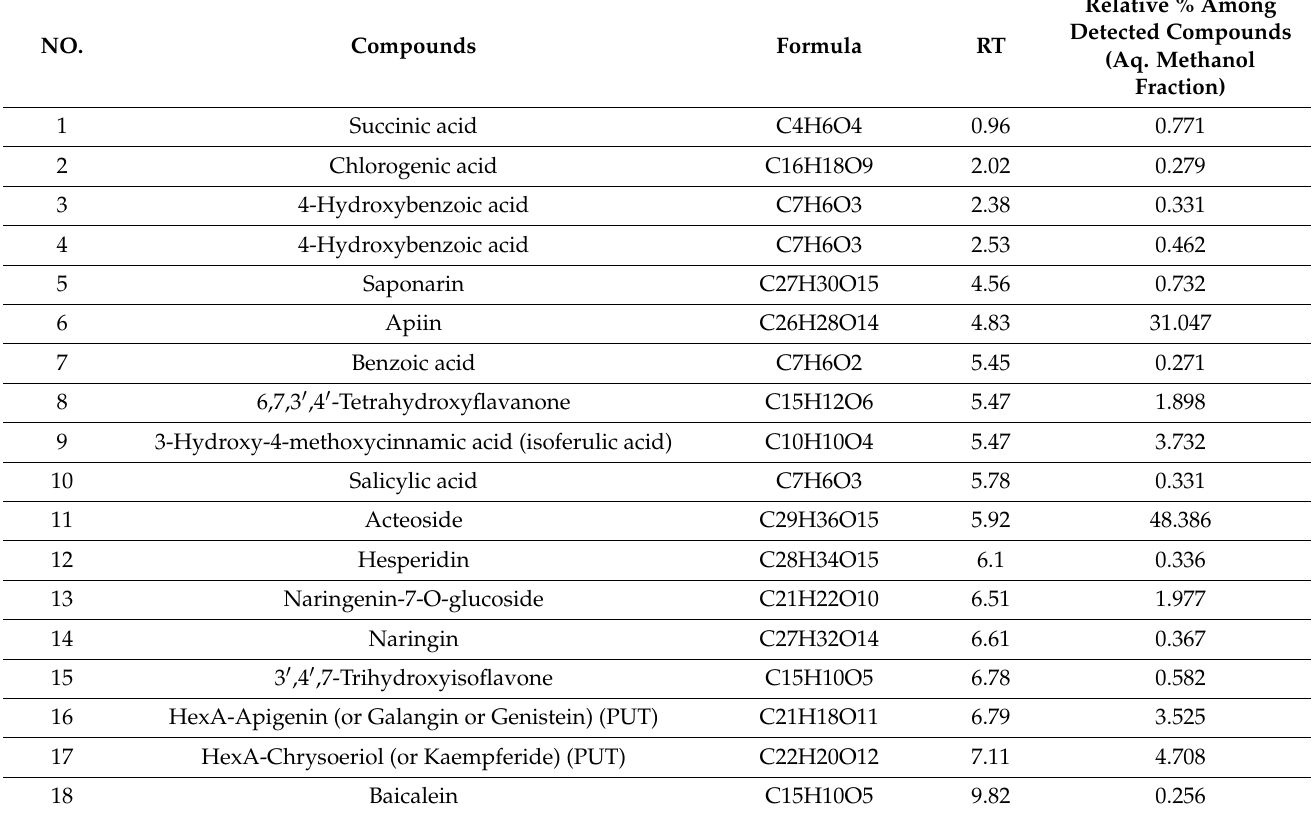
Table 4. LC-MS analysis of X. spinosum aq. Methanol fraction.